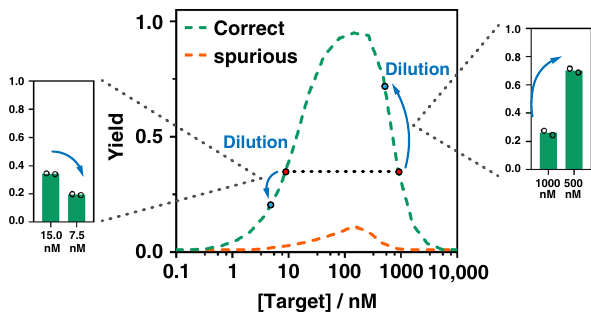
Fig. 8 A dilution strategy to narrow the concentration range for quantifying target nucleic acid. Experimental demonstration of a representative scenario, where the same detection signal corresponds to two possible concentrations of the same target. The yield of 0.35 corresponds to either 15 nM or 1 µ M of the correct dsDNA target. After a 2 × dilution step, the original 1 µ M target concentration (500 nM after dilution) produced an even higher detection signal (0.8) whereas the signal of the original 15 nM target concentration (7.5 nM after dilution) decreased to 0.2. Individual replicates ( n = 2) are shown as circles. Source data are available in the Source Data fi